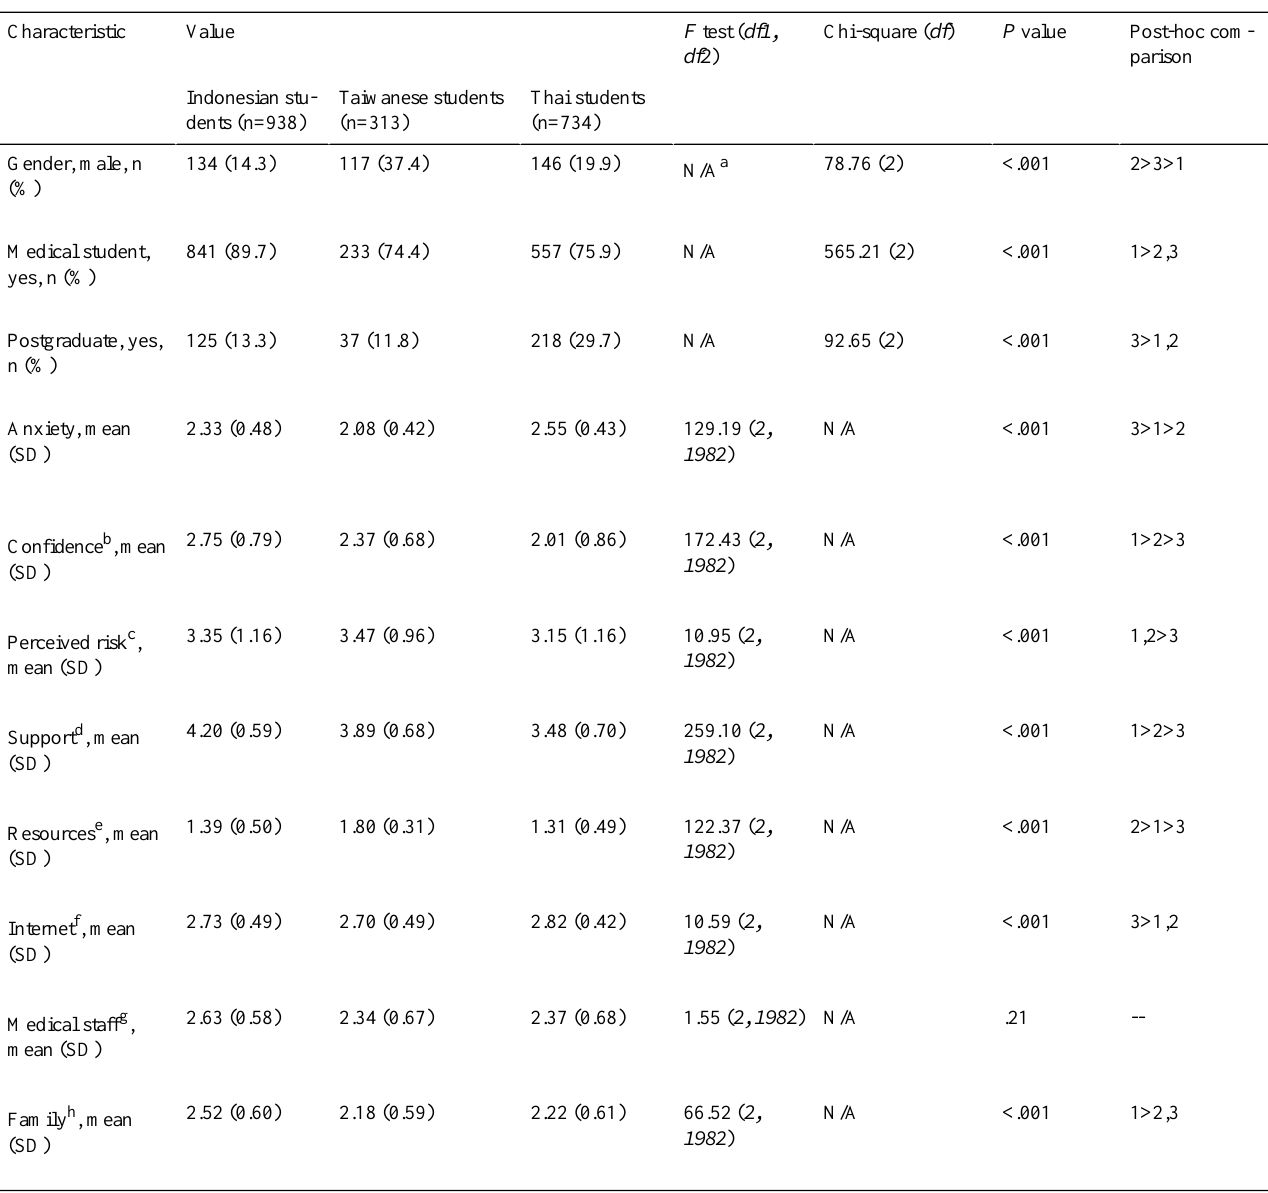
Table 1. Participant characteristics in different groups